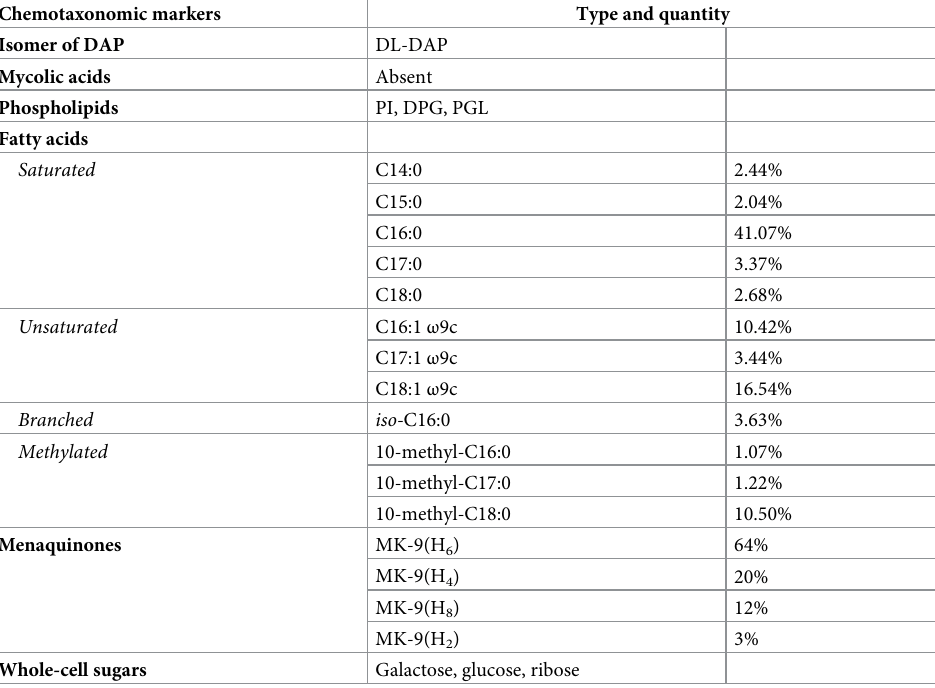
Table 3. Summary of the main chemotaxonomic markers of Actinomadura sp.